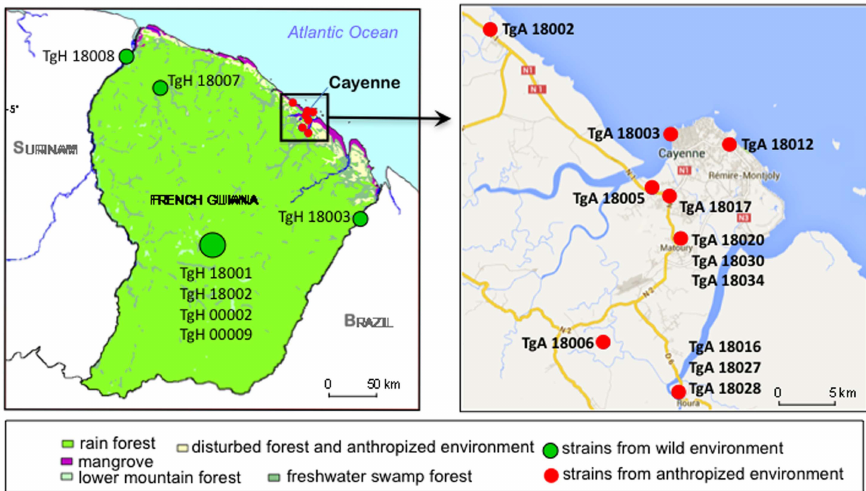
Figure 1. Distribution of strains from French Guiana. Map of French Guiana shows locations of strains collected from the wild Neotropical rainforest (7 strains, green points) vs. anthropized environment (12 strains, red points). Of the 7 wild strains, only 3 (TgH18003, TgH18007, and TgH18008) were mapped with precision in the rainforest. Because information is lacking for the remaining 4 wild strains in the Neotropical rainforest (TgH18001, TgH18002, TgH00002, and TgH00009), they are shown as a large green point in the center of the rainforest area. For strains from the anthropized environment, each point corresponds to the localization of one or more isolates sharing the same geographic origin.